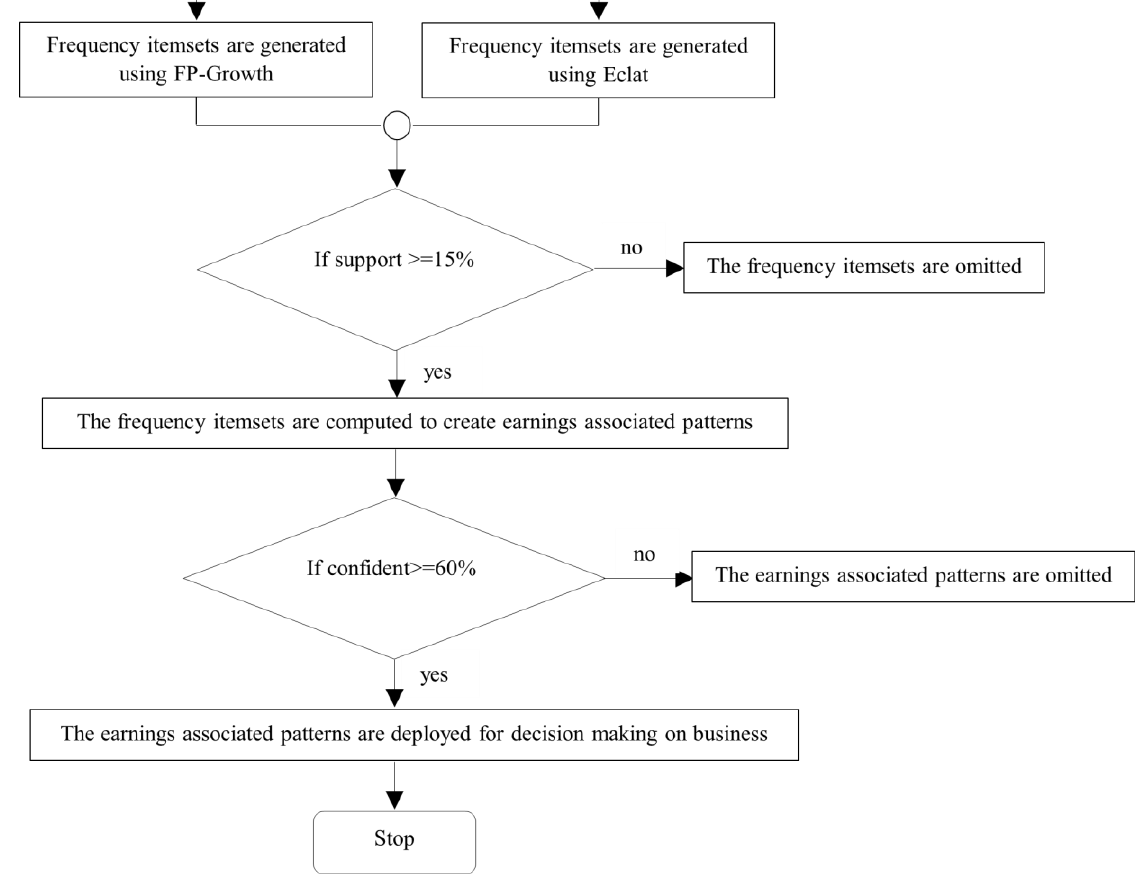
Figure 1. Proposed method for identifying future earnings